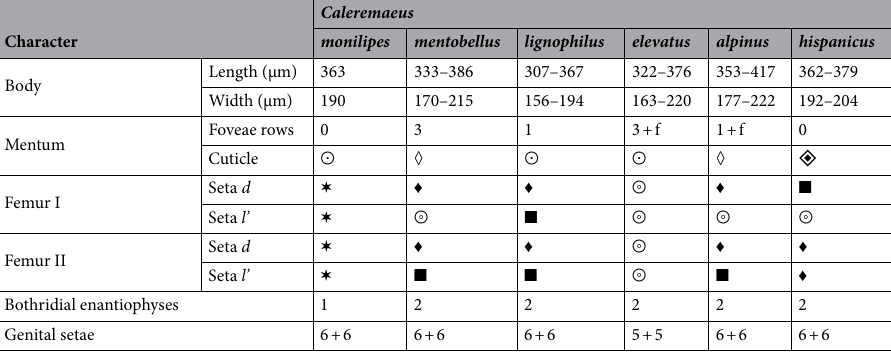
Table 1. Comparison of diagnostic characters of Caleremaeus species. f = few foveae laterally; ⊙ = finely granulate, ◈ = finely rugose, ◊ = finely rugose in anterior half of mentum, ✶ = very stout and spinose, ♦ = stout and spinose, ⊚ = spiniform and smooth, ■ = spiniform with tiny barbs.